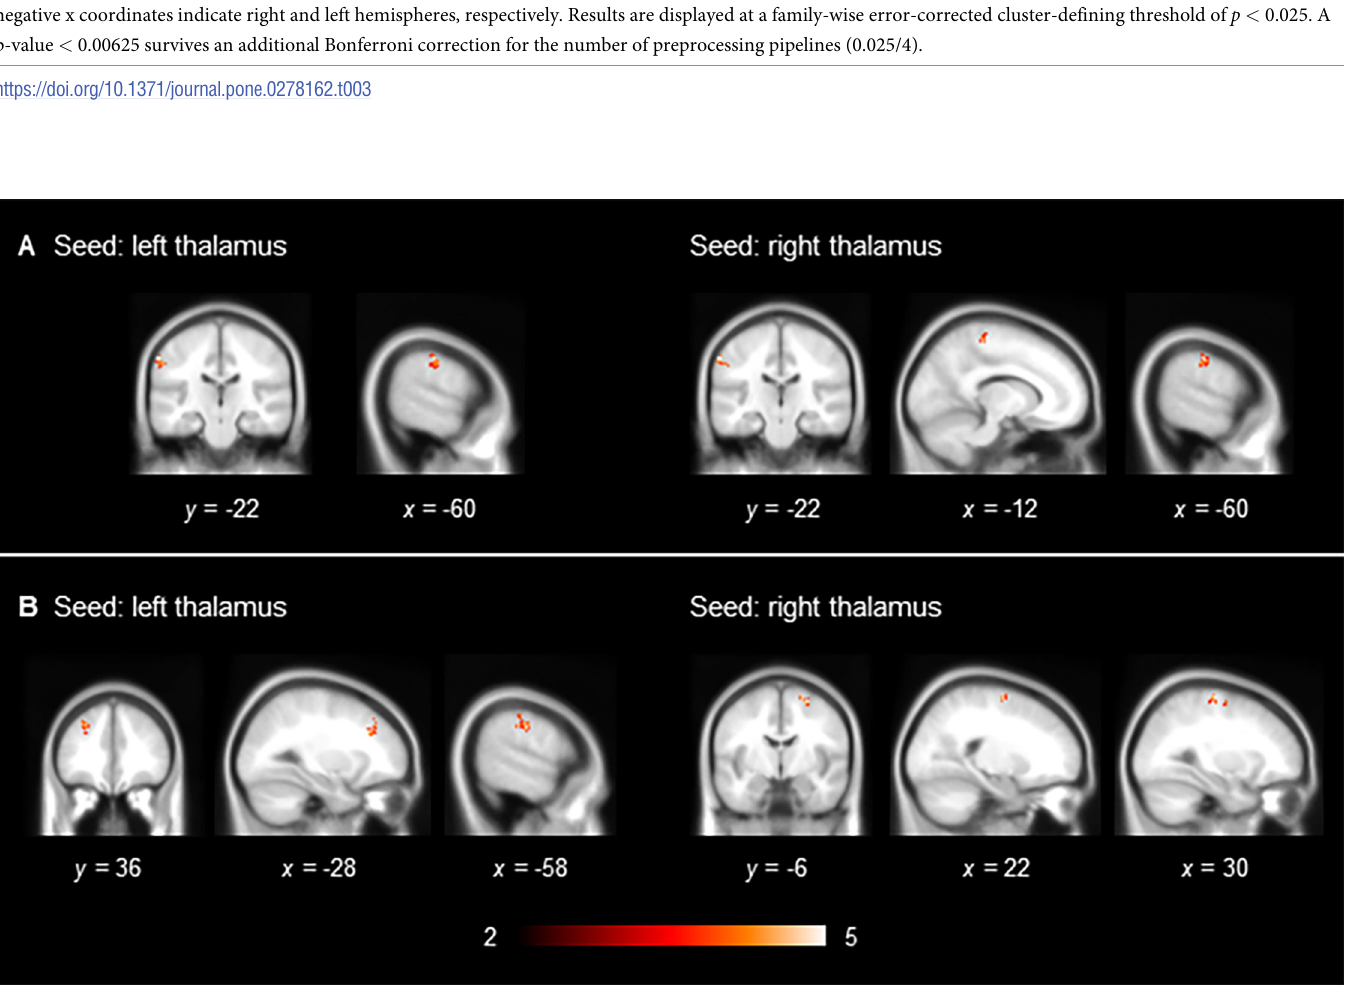
Fig 2. Significant increase in thalamic functional connectivity in adult cannabis non-users with a childhood diagnosis of ADHD compared with cannabis non-users without a childhood diagnosis of ADHD. (A) Scrubbing (+), global signal regression ( − ) and (B) scrubbing ( − ), global signal regression ( − ). Results are displayed at a family-wise error-corrected cluster-defining threshold of p <